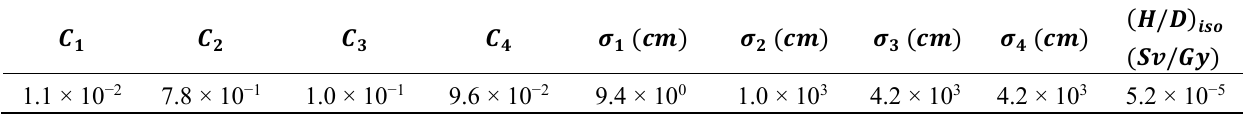
Figure 10. Measured (circles) and calculated (lines) 𝐻/𝐷 values for the ocular beamline plotted vs. distance from isocenter. The top plot shows data taken along the beam axis with points distal to isocenter. The middle plot shows the values along a ray 45° with respect to the beam axis. The lower plot shows values directly lateral to isocenter, i.e. , along a ray 90° with respect to the beam axis. Table 5. Model parameters for ocular